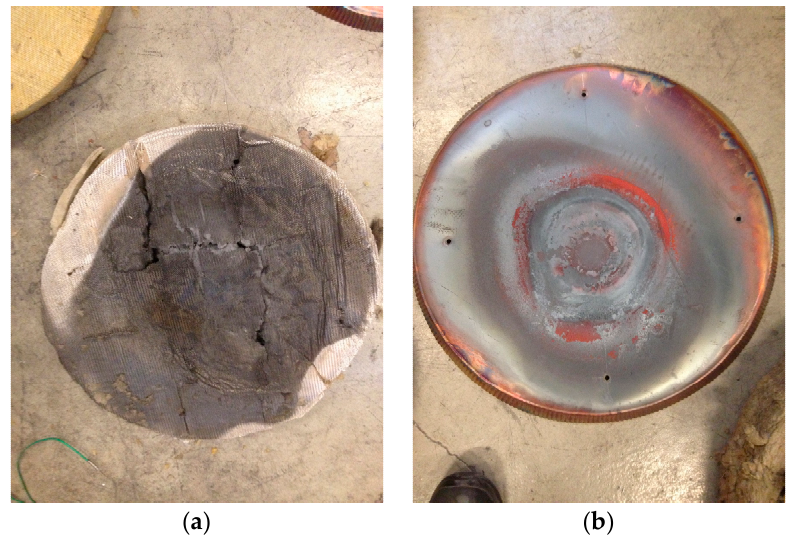
Figure 11. Thermal insulation ( a ) and cladding ( b ) after Test 1.